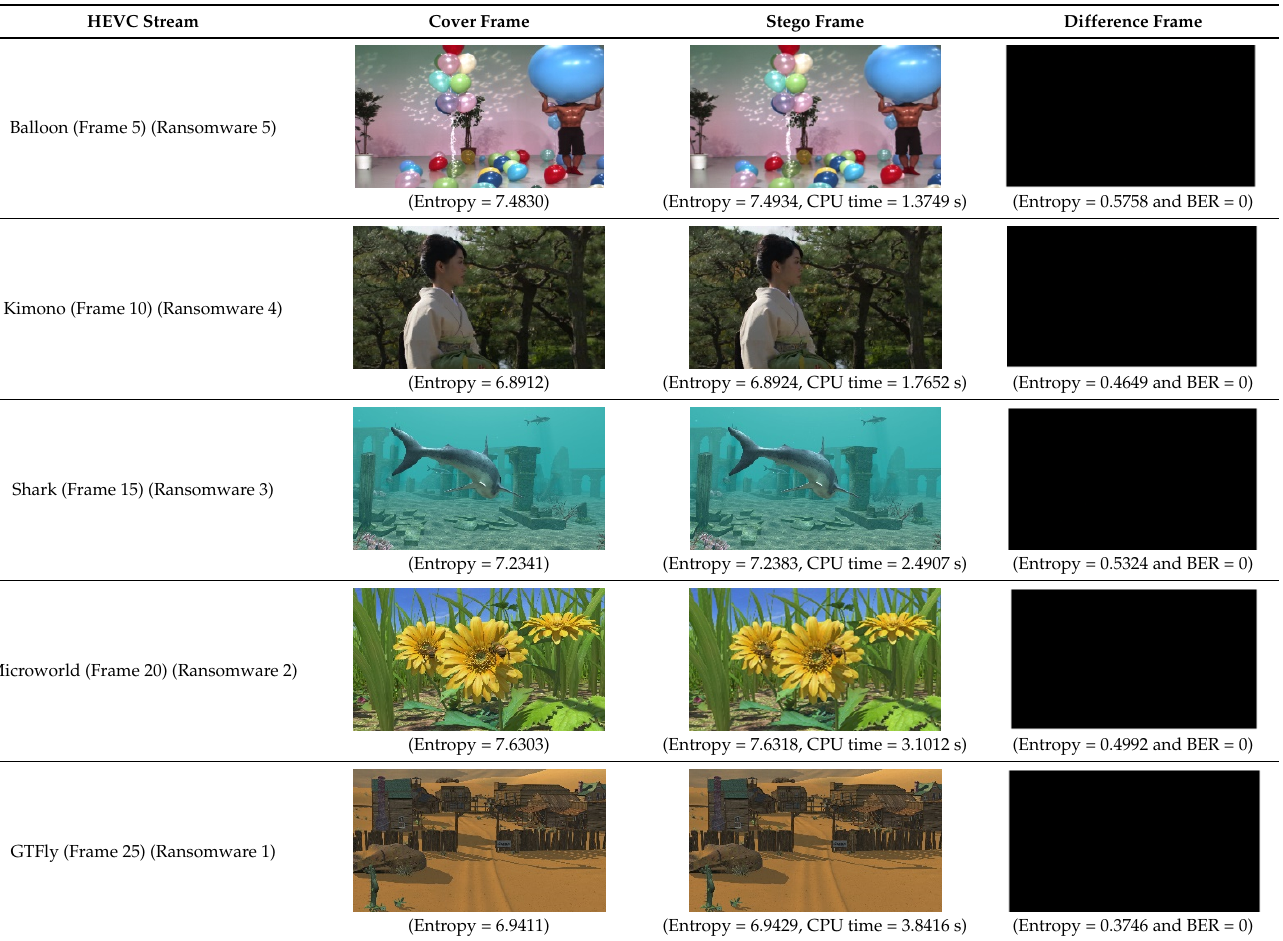
Table 4. The employed objective quality assessment